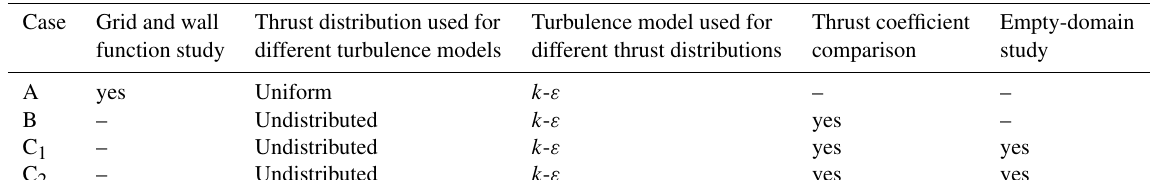
Table 4. Overview of the cases for which results will be presented. Case